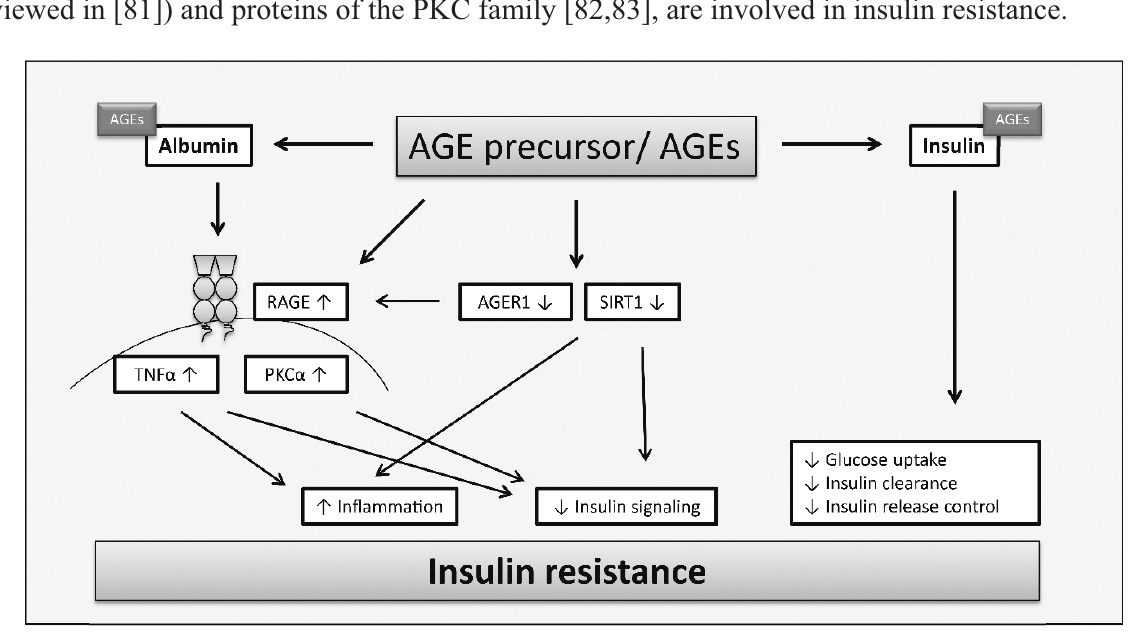
Figure 3. Mechanisms of AGEs leading to insulin resistance in insulin-sensitive tissues according to [52,78–80,84–86]. AGEs are involved in mechanisms contributing to insulin resistance due to direct modification of insulin which alters insulin action resulting in impaired glucose uptake, inhibited insulin clearance or further increased insulin secretion. Furthermore, AGEs may contribute to insulin resistance via increased expression of RAGE and reduced expression of AGER1 and SIRT1. AGEs affect insulin signaling and trigger inflammation via stimulation of PKC(cid:7) and upregulation of TNF(cid:7). SIRT1 depletion causes changes in insulin signaling and induces